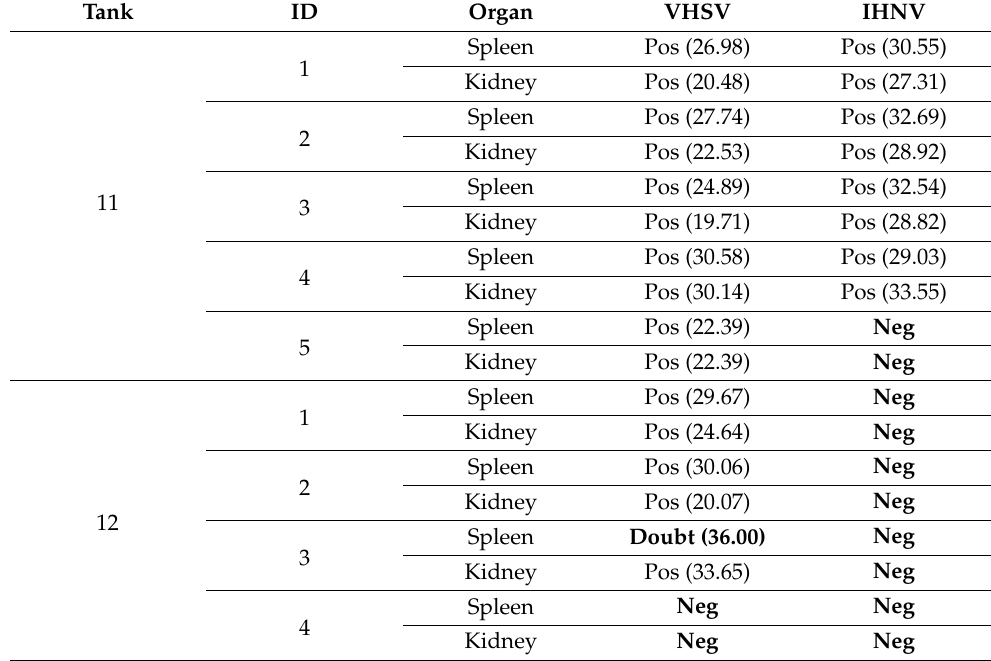
Table 5. VHS and IHN real-time RT-PCR results from spleen and kidney sampled from dead fish retrieved from tank 11 and 12. When positive, cycle threshold values (Ct) are given in